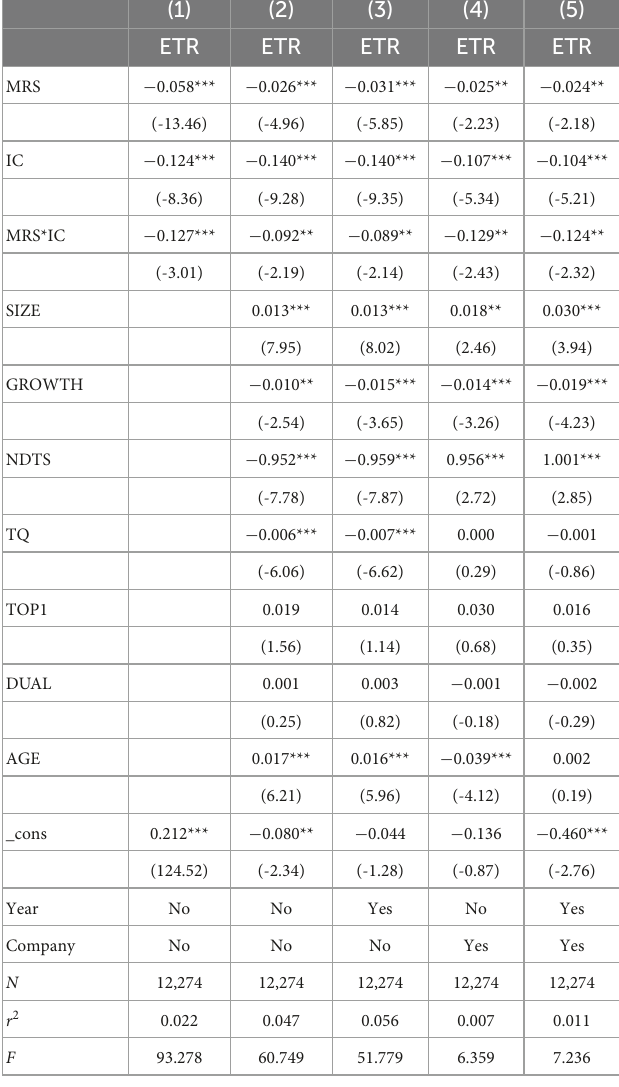
TABLE 8 Robustness test results of the moderating effect of internal